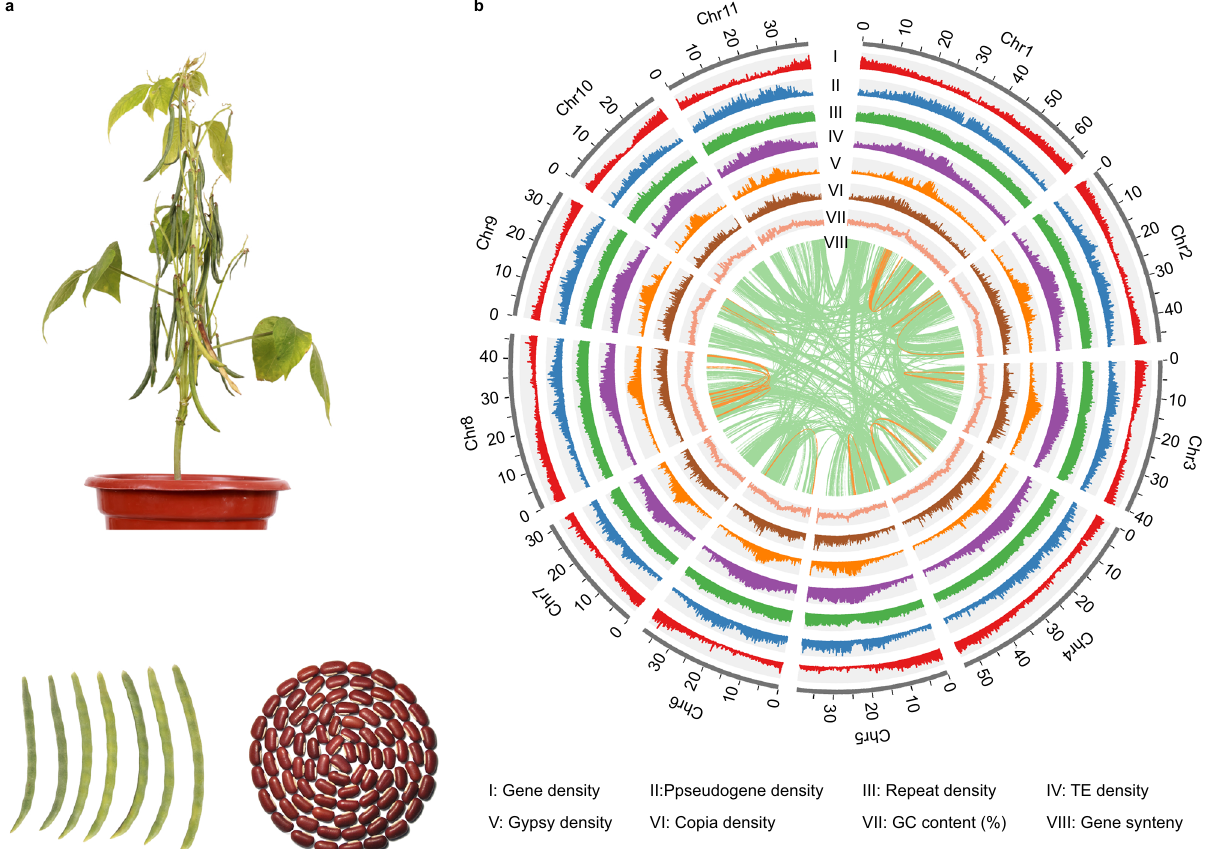
Fig. 1 | FF25 genome assembly. a FF25 plant (Top); FF25 pod (Bottom left); FF25 seeds (Bottom right). b Genomic features of the FF25 reference genome. The outer gray track represents the chromosomes of the FF25 genome assembly (with